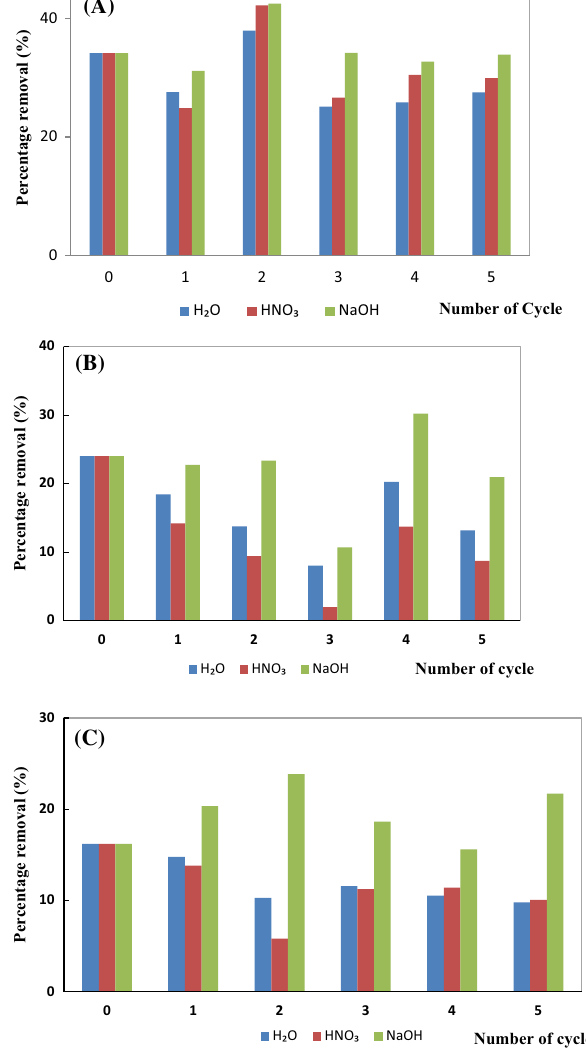
Fig. 6 Regeneration experiment of a WL, b TP and c